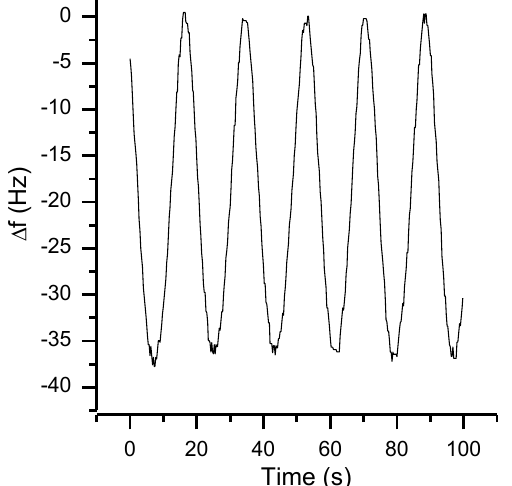
Figure 18. Frequency response of a rotation around the sensors x axis with a constant angular speed of 0.6 rpm.